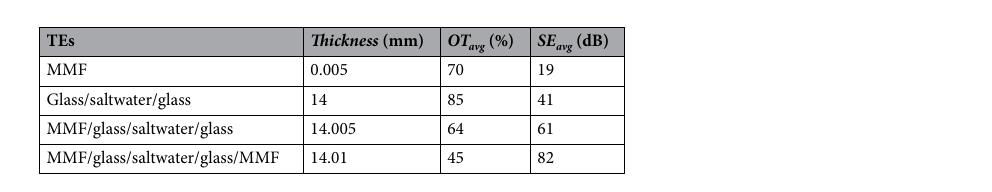
Table 1. Summarized OT and SE of the proposed